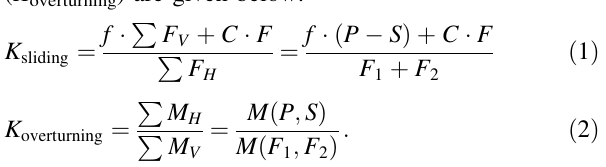
Table 4 summarizes the results of the dam stability